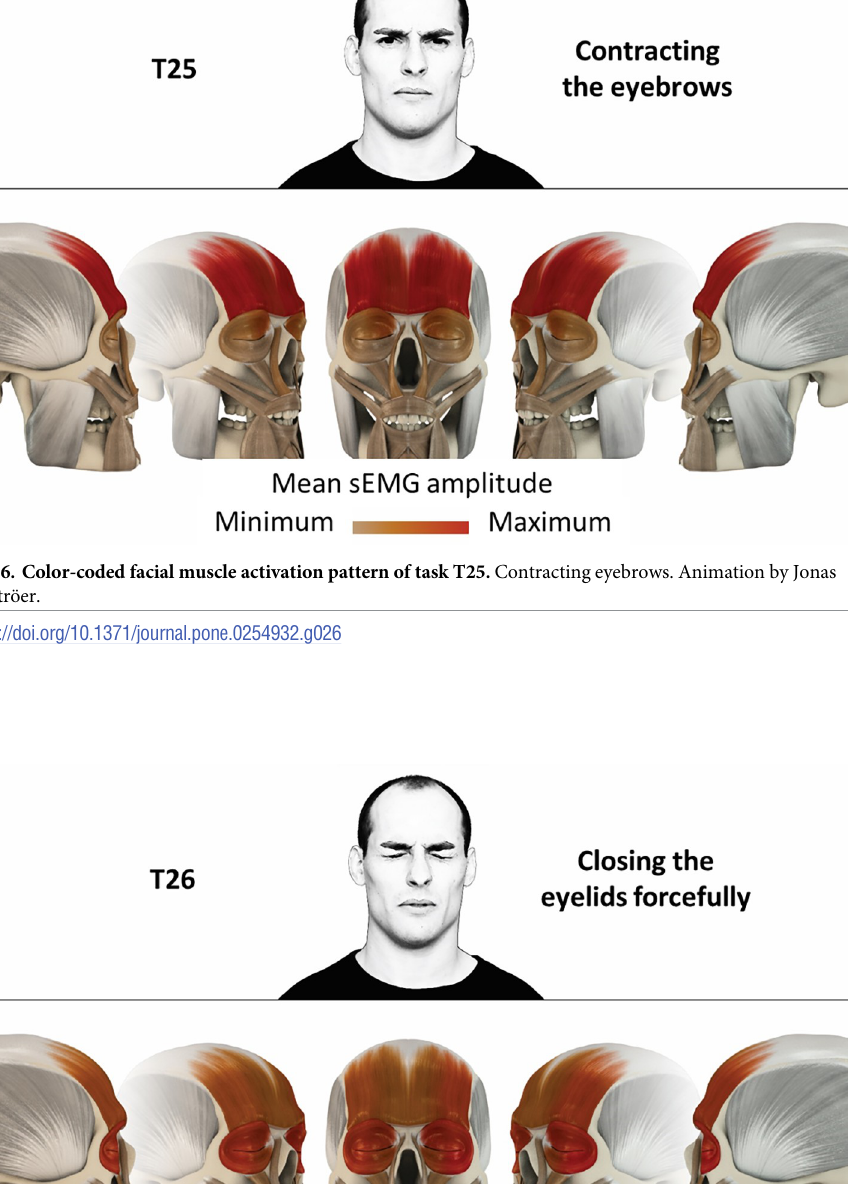
PLOS ONE | https://doi.org/10.1371/journal.pone.0254932 July 19,